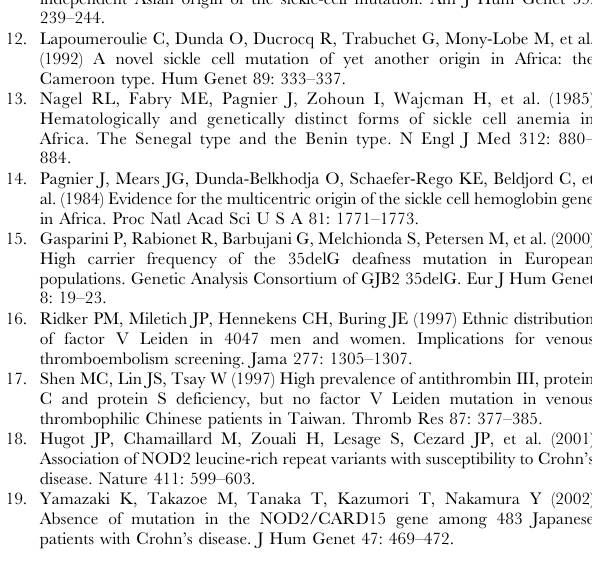
indicate recent selection (marked with two asterisks). *: denotes population using the observed values. It is also used to indicate XLS) Figure S1 Evaluation of copy number in large CNVs. MLPA probes located within the same theoretical CNV do not show the same copy number pattern neither, in consequence, the same correlation with gene expression levels. PNG) Figure S2 Correlation between copy number changes and expression levels. Each coloured circle corresponds to the measured copy number state plotted against expression levels for each HapMap individual. Gene name for which expression levels and copy numbers are depicted is shown in the title of each figure. Left panel (A) shows four examples of CNVs identified in which copy number is correlated with gene expression. Right panel (B) exemplifies four cases in which copy number differences exist among individuals from different populations, but it does not translate into gene expression differences. Found at: doi:10.1371/journal.pone.0007230.s012 (5.57 MB